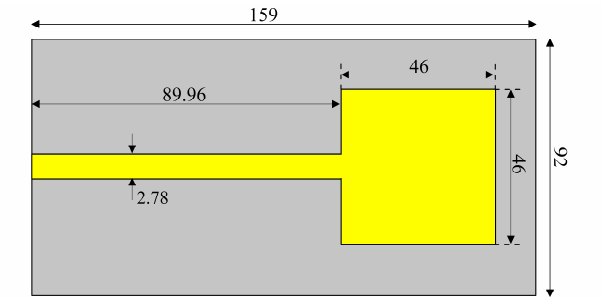
Figure. 1. The dimensions of A 1 antenna in